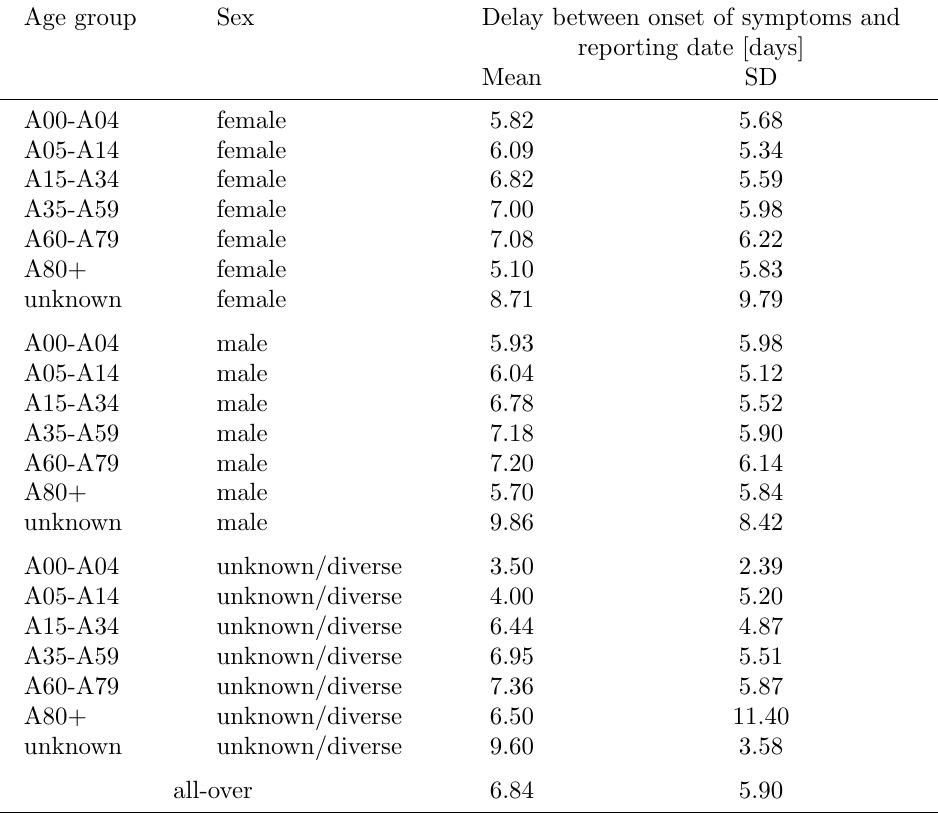
Table 3: Delay between onset of symptoms and official report by age group and sex Age group